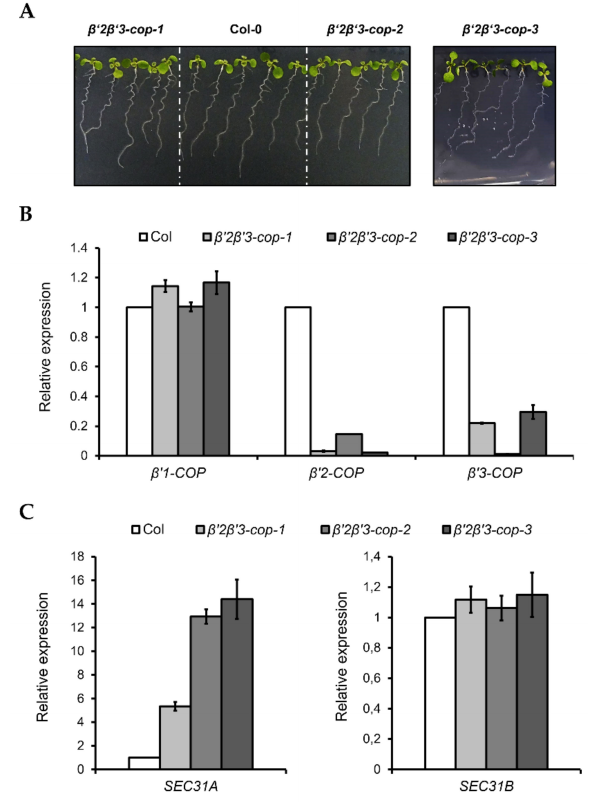
Figure 4. Characterization of β ’2 β ’3-cop double mutants. ( A ) All the β ’2 β ’3-cop double mutants show a wild type phenotype at 7-day-old seedling stage. ( B ) RT–qPCR analysis show the expression levels of the three β ’-COP genes. ( C ) β ’2 β ’3-cop-1 , β ’2 β ’3-cop-2 and β ’2 β ’3-cop -3 mutants show upregulation of the COPII subunit SEC31A gene. Expression of SEC31A and SEC31B was analyzed by RT–qPCR. Total RNA was extracted from 7-day-old seedlings of the mutants and wild type (Col-0). The mRNA was analyzed by RT–qPCR with specific primers and normalized to UBQ10 expression (Supplementary Tables S1–S3). Results are from three biological samples and three technical replicates. mRNA levels are expressed as relative expression levels and represent fold changes of mutant over wild type. Values represent mean ± s.e.m. of the three biological